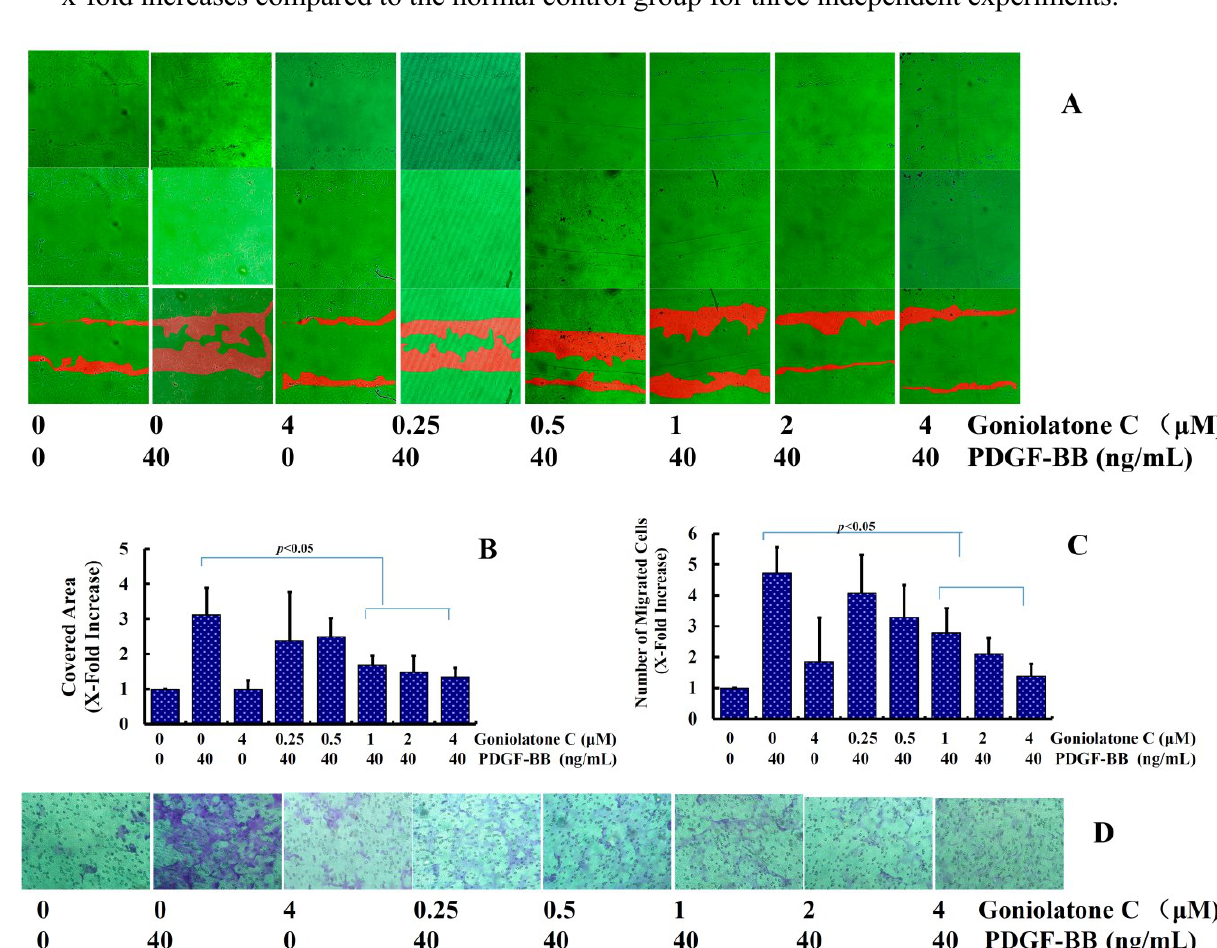
Figure 4. Goniolactone C inhibits PDGF-BB-induced adhesion molecule expression and VSMC migration. VSMCs were treated with goniolactone C at different concentrations (0–4 μM) for 12 h and were then incubated with PDGF-BB for another 12 h. (A and B) A wound-Healing assay was used to determine VSMC migration. Four different fields of migration were photographed using a video camera system and Image Pro-Plus 5.1 Software (Media Cybernetics, Silver Spring, MD, USA) at the intersection of the previously marked line and the wound edge, both prior to and after treatment with PDGF-BB. The migration activity was expressed as the change in the covered area. The samples were run in triplicate in three independent experiments. ( A ) The upper, middle, and bottom images represent the beginning point, end point, and merged images, respectively. The red shadow represents the change in the covered area. ( B ) Change in the covered area. (C and D) A modified Boyden Chamber Assay was applied to measure VSMC migratory ability. ( C ) The number of cells that had migrated to the lower surface per field. ( D ) Cells that had migrated through the 8-μm pores were stained with hematoxylin. ( E ) Levels of VCAM-1 and ICAM-1, as determined using ELISA. The relative levels of these proteins are expressed as x-fold increases compared to the normal control group for three independent